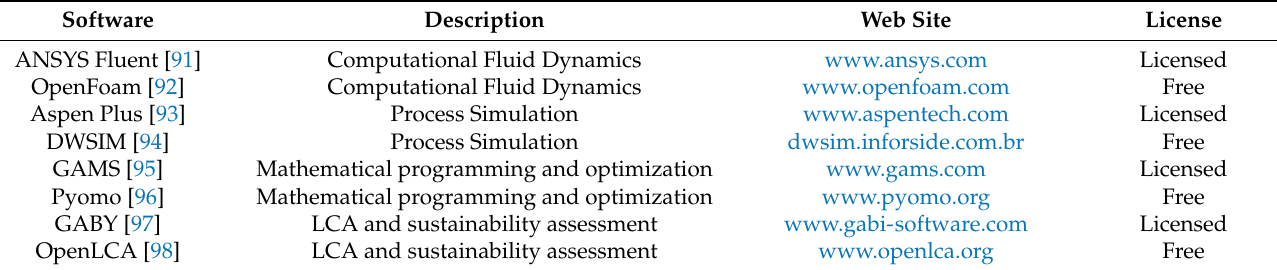
Table 1. Licensed and free computational tools, used for process simulation, synthesis/optimization, and sustainability assessment. Software